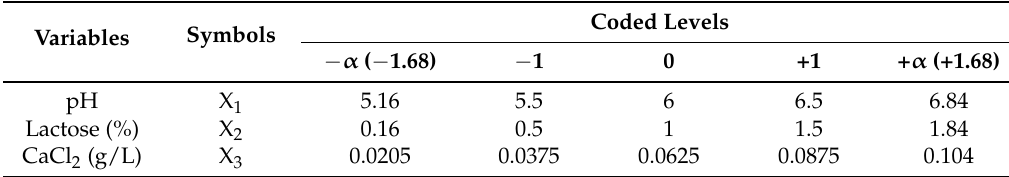
Table 3. Experimental codes, ranges and levels of the independent variables for response surface methodological